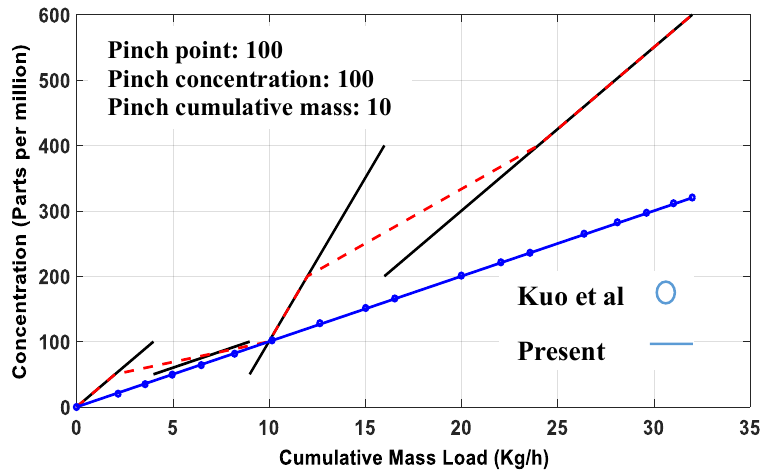
Figure 4. Comparison of Kuo and smith results with the written program